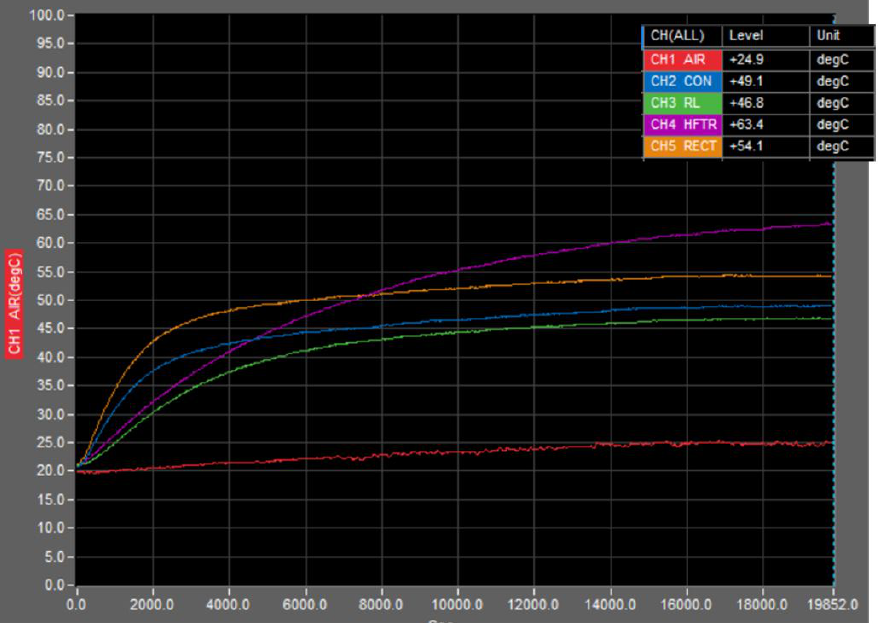
Figure 17. The results of the temperature rise test at 50% load in case of resonant